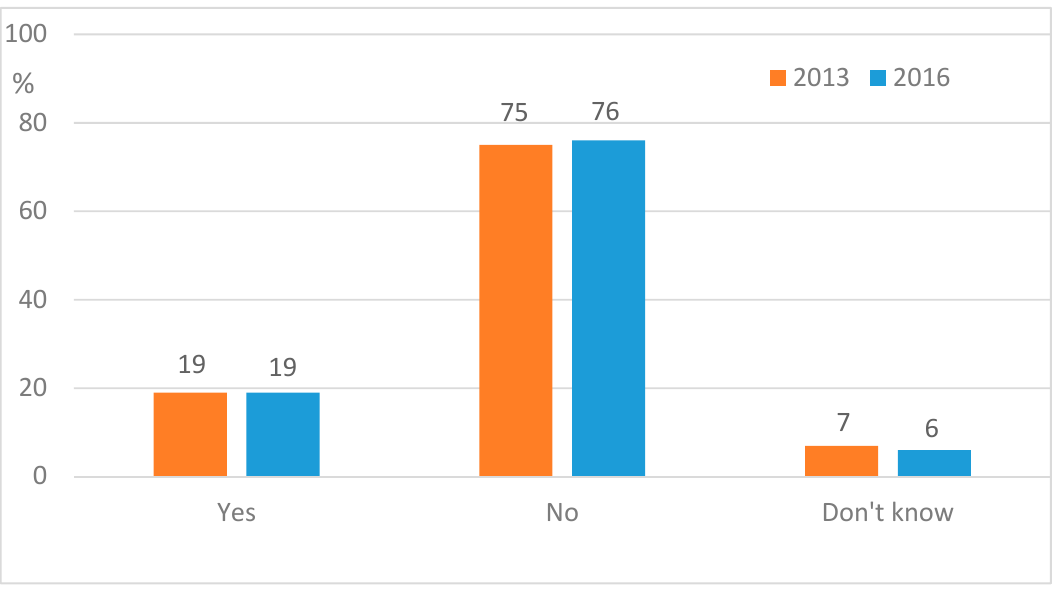
Figure 6. Question just to the MPs: Do you think we should leave it to the experts on nuclear waste to decide about how we should manage our nuclear waste?